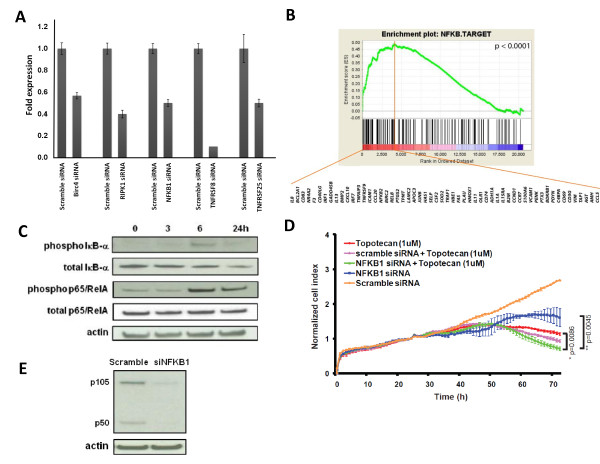
Up-regulation of NF-κB pathway protects NB cells from tepotecan-mediated growth inhibition. (A) Quantitative RT-PCR was performed on the 5 enhancer genes (Birc4, RIPK1, NfKB1, TNFRSF8 and TNFRSF25) to confirm target gene knockdown. Each gene expression is normalized with GAPDH and compared to siRNA control. Error bar represents the standard deviation of triplicate experiment. (B) GSEA analysis was performed on the ranked genes according to log2 ratio of gene expression between topotecan-treated and control SK-N-AS cells. The NF-κB target genes are significantly enriched in SK-N-AS cells treated with topotecan at 1 μM (p < 0.0001). The green curve shows the running sum of enrichment score (ES) for the ranked genes. Black vertical lines indicate gene hits in the NF-κB target gene set. The red vertical line marks the leading edge subset genes, and the NF-κB target genes within the leading edge subset genes are shown in their gene symbols. (C) Immunoblots showed activation of the NF-κB pathway by topotecan (5 μM) through phosphorylation and degradation of total IκB-α protein; and phosphorylation of p65/RelA in a time dependent manner. (D) Knockdown of NFKB1 potentiated the inhibitory effect of topotecan on cell growth when compared to topotecan alone (p = 0.0086), or NFKB1 siRNA alone (p = 0.0045) on a real-time cell electronic sensing system. (E) Immunoblots confirmed knockdown of NFKB1 protein (p105/p50 complex) of SK-N-AS cells transfected with NFKB1 siRNA for 72 hrs compared to scramble siRNA